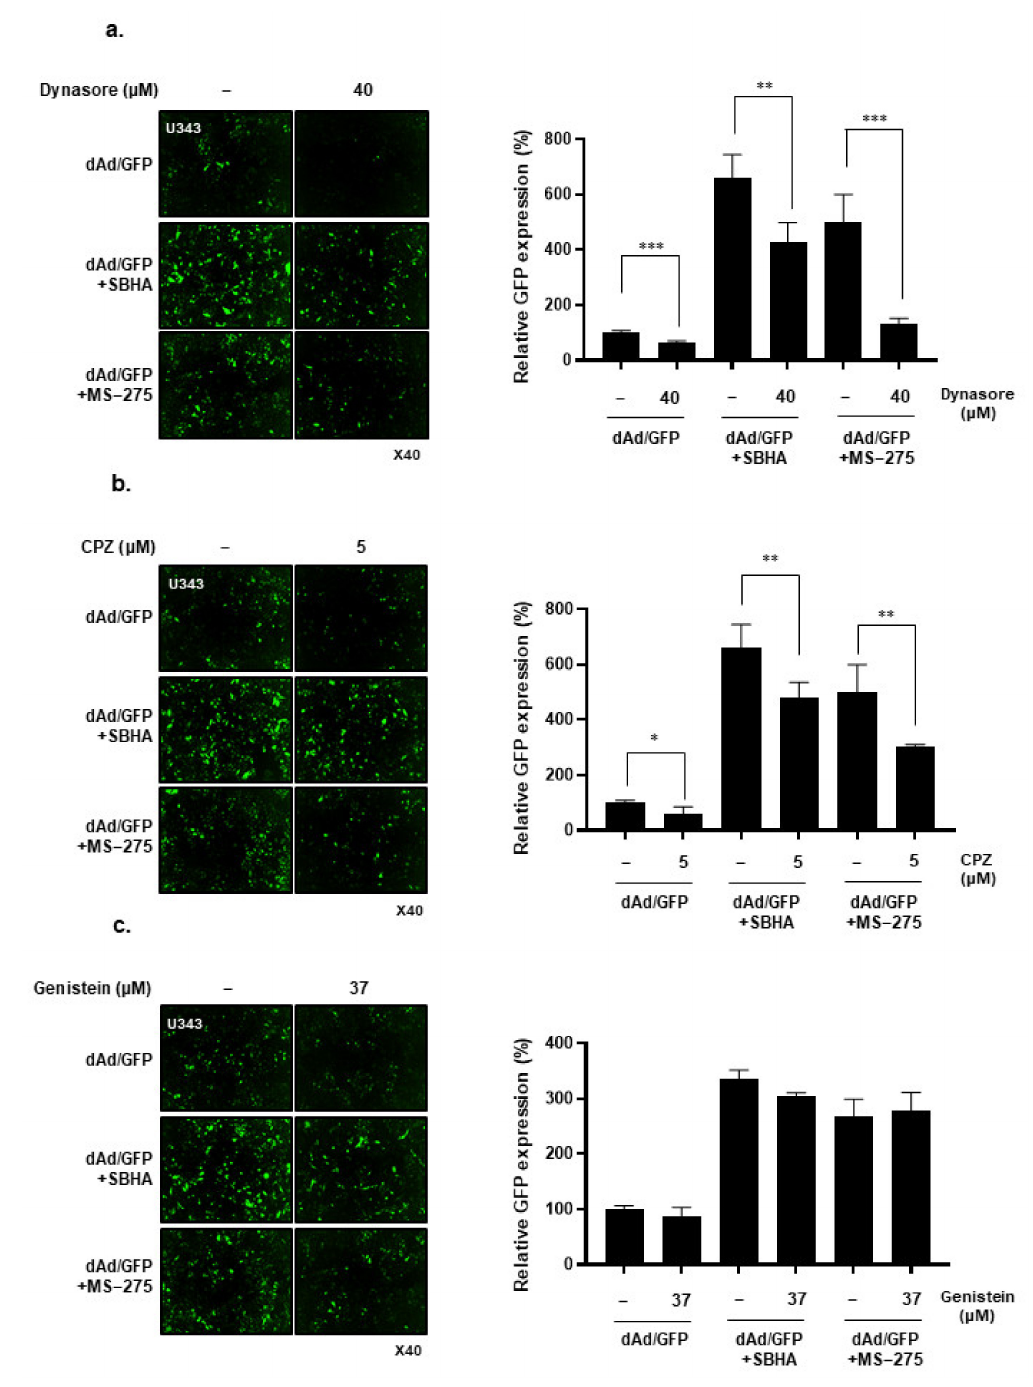
Figure 3. Endocytosis mechanism of Ad in combination with HDACi: ( a ) U343 cells were pretreated with ( a ) dynamin 2 inhibitor (dynasore—40 µ M), ( b ) clathrin inhibitor (CPZ—5 µ M), or ( c ) caveolin inhibitor (genistein—37 µ M) for 45 min. Subsequently, the cells were treated with dAd/GFP, dAd/GFP+SBHA, or dAd/GFP+MS-275. At 24 h post transduction, cells were analyzed for GFP expression by using the IncuCyte ® Live-Cell Analysis System (Sartorius). The data are representatives of three independent experiments performed in triplicate. Representative images are shown. Original magnification: × 40. Bars represent the mean ± SD. * P < 0.05, ** P < 0.01, *** P <